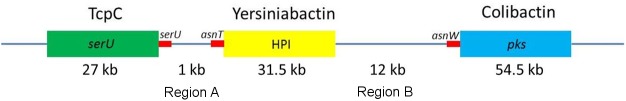
The arrangement of the PAIs on the chromosome.Each island is inserted in a tRNA (serU island: serU tRNA; HPI: asnT tRNA; pks island: asnW tRNA). The size is given in kilobases (kb). The regions between the PAIs are called inter-PAI regions (between the serU island and the HPI (region A): about 1 kb; between the HPI and the pks island (region B): about 12 kb).